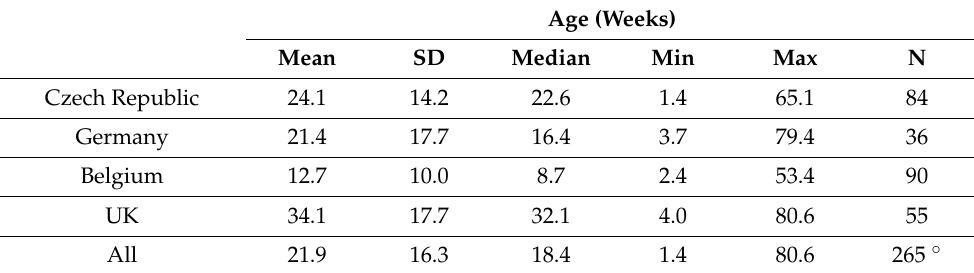
Table 3. Age distribution of included infants per country.